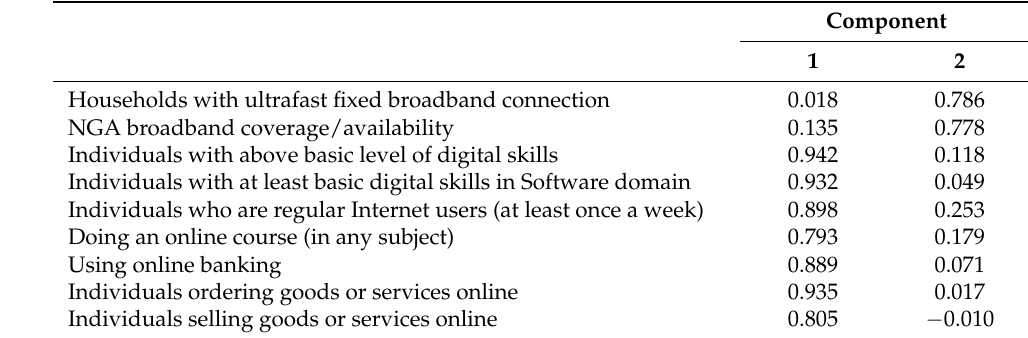
Table 4. Rotated Component Matrix.